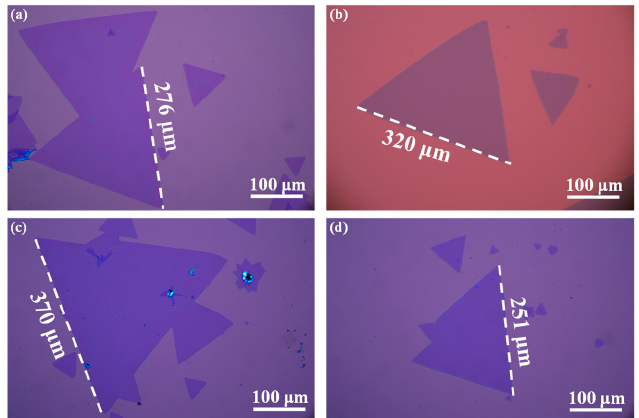
Figure 6. ( a–d ) Representative optical images of the as-grown WS 2 flakes on the covering SiO 2 /Si substrates obtained from different batches of experiments under the same conditions (950 ° C for 5 min.).